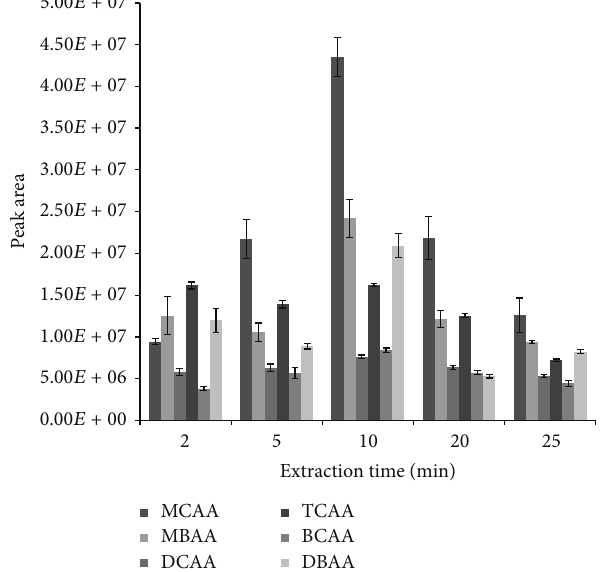
Figure 2: Effect of reaction time on the simultaneous liquid-liquid microextraction and derivatization of 0.5 𝜇 gL −1 haloacetic acids at experimental conditions of 5 𝜇 L TFAA as catalyst, temperature of 25 ∘ C, and 1 mL n -octanol as both extractant solvent and derivatiza- tion